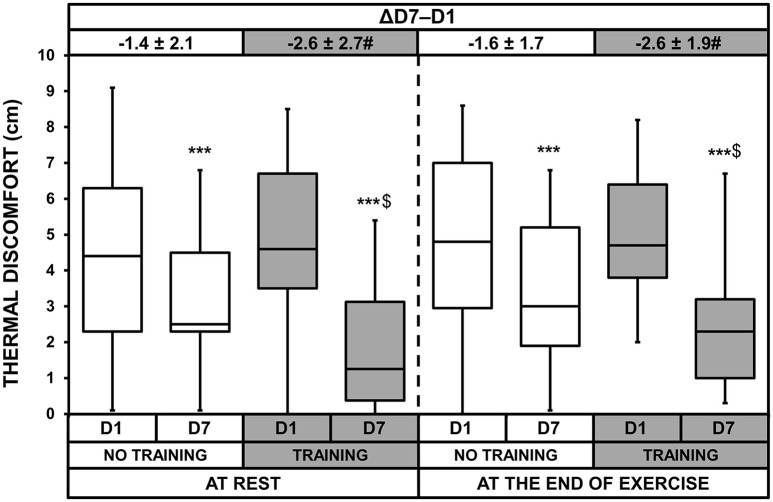
Box-and-whisker plots for thermal discomfort of the No Training and Training groups before (D1) and after (D7) heat acclimatization, at rest and at the end of exercise. The box encompasses the 25–75% quartiles, and the median is represented by the horizontal line within the box. The whiskers extend to the highest and lowest values. Values shown above the boxes, at the top of the plot, correspond to the differences (mean ± SD) between D7 and D1. Significantly different from D1, ***p < 0.001; significantly different from NT group, $p < 0.05; ΔD7-D1 significantly different from NT group, #p < 0.05.